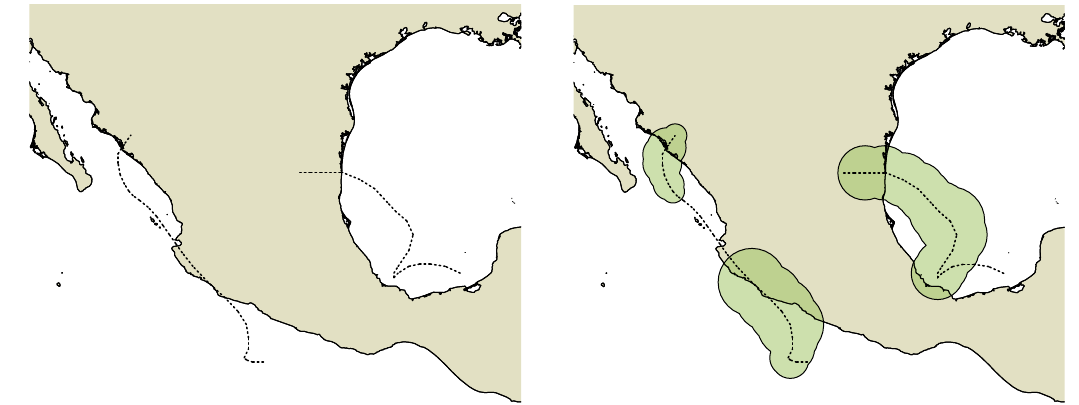
Figure 3. Transformation of the cyclone track to 34-knot boundaries (cyclones Manuel and Ingrid, 2013). The second hazard factor is rainfall. Total precipitation from the ECMWF ERA Interim dataset [25] was summed throughout the whole time of cyclone activity (Figure 4a). Rainfall can also be represented by cloudiness throughout the cyclone region (Figure 4b).